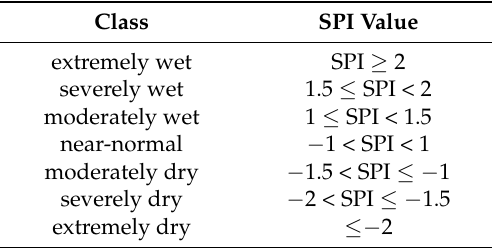
Table 1. Standardized Precipitation Index (SPI)